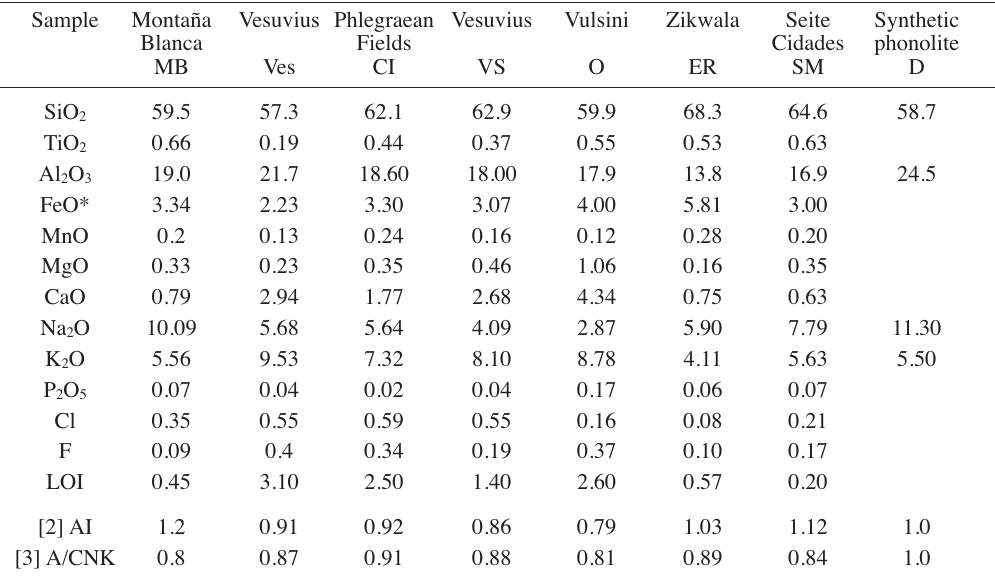
Table I. Composition (wt%) on water free basis of experimental starting materials.